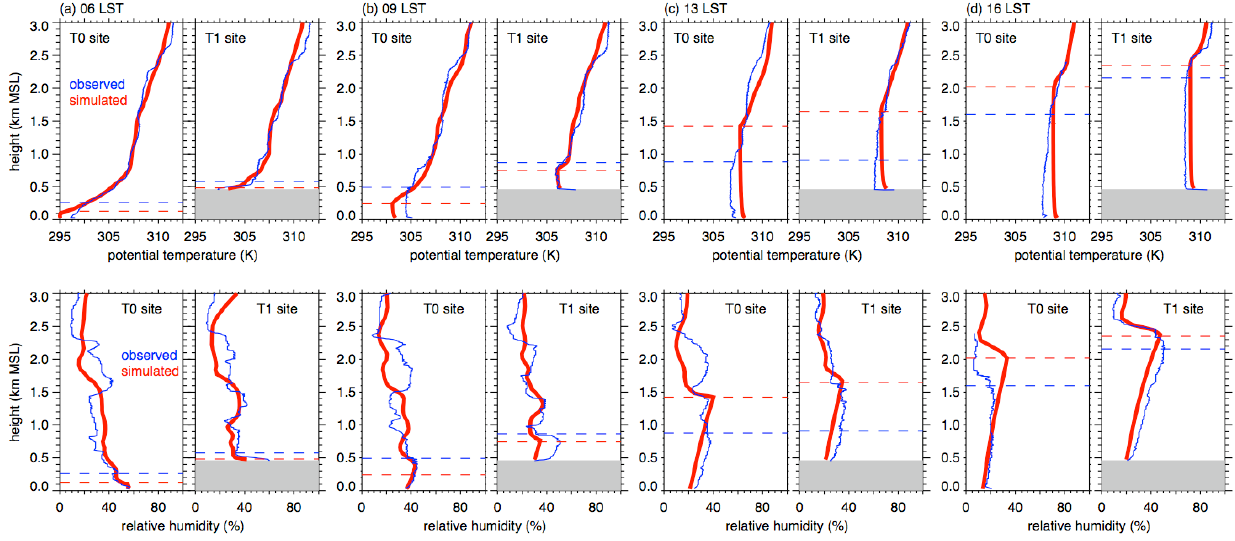
Figure 8. Observed (blue) and simulated (red) potential temperature and relative humidity profiles (solid lines) and boundary layer depths (dashed lines) at the surface sites on June 28, 2010. Radiosonde at 11 LST was not launched on this day. Gray shading denotes terrain height at the T1 site.